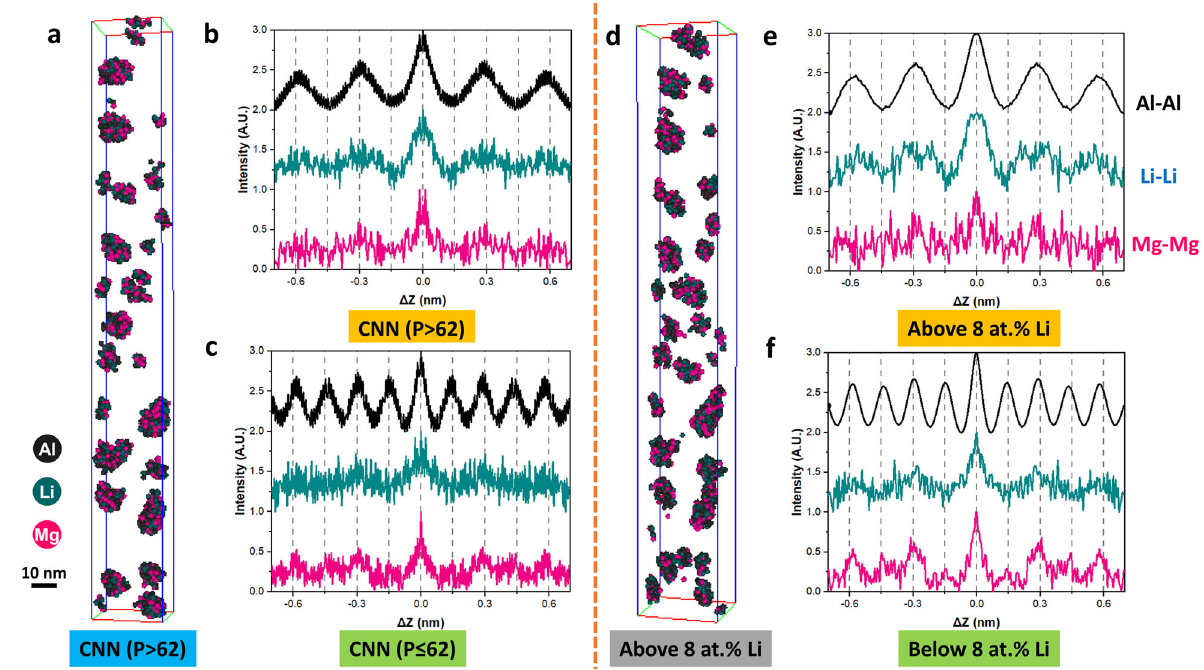
Fig. 6 Comparison of 3D atom tomography of L1 2 ordered structures revealed by two methods. 3D atom probe tomography of precipitates ( a ) by the proposed CNN approach with the predicted L1 2 structure probability (P) above 62 and ( d ) by the previous report using 8 at% Li isocomposition. For ( a ), the corresponding species-speci fi c intensity distributions along the z-axis in the z -SDMs with the L1 2 structure probability above ( b ) and below ( c ) 62. For ( d ), the corresponding species-speci fi c intensity distributions along the z-axis in the z -SDMs of above ( e ) and below ( f ) 8 at% Li.